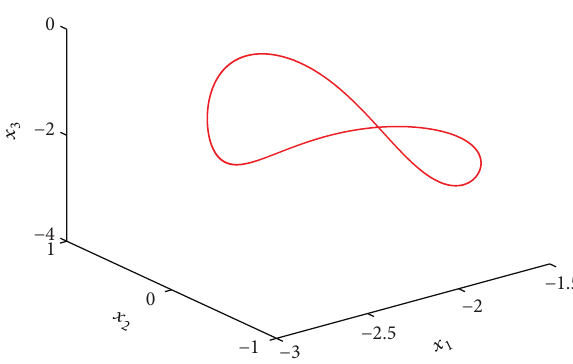
Figure 2: Periodic solution of the viscoelastic moving belt